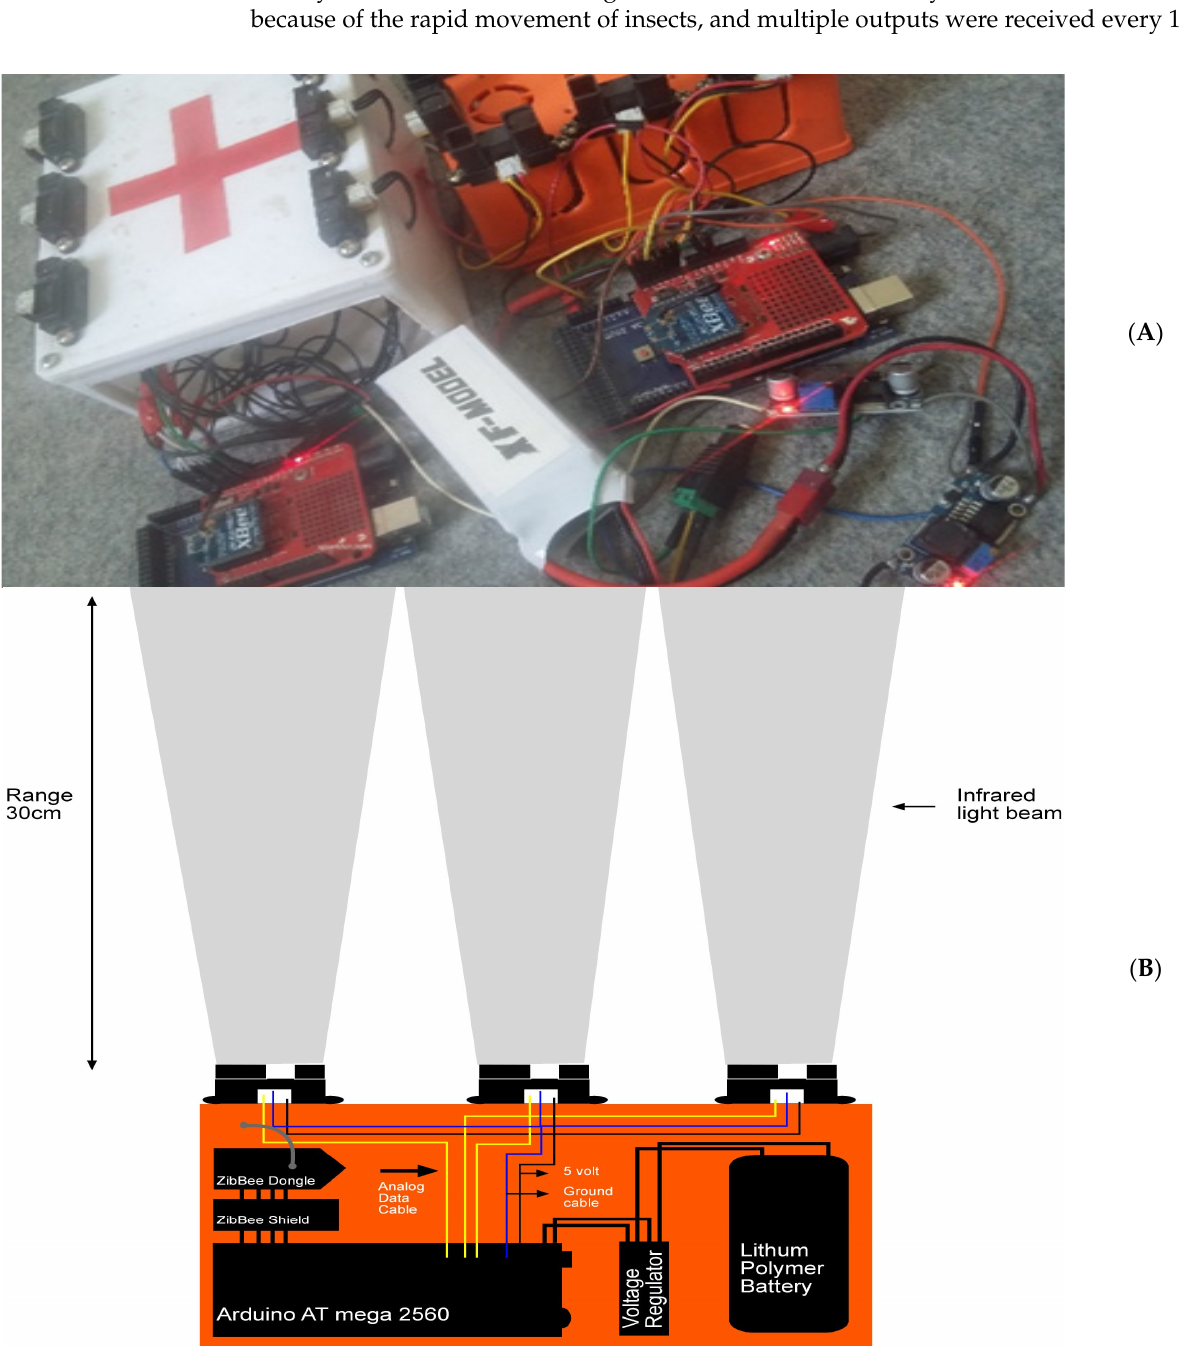
Figure 5. ( A ) A fully assembled wireless node consists of Arduino Uno, Zigbee, sensors, and battery. ( B ) Conceptual diagram of a node. ( B ) Conceptual diagram of a